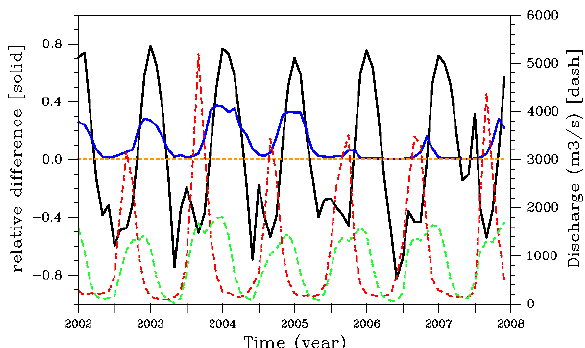
Fig. 6. Time evolution of the relative difference of simulated total evaporation between the simulation NOAQ-NF(1) and NOAQ-F(2) when the model is forced by TRMM-3B42 (solid blue line). The relative difference is the ratio ((2) − (1))/((2)+(1)). Time evolution of the relative difference of observed discharge between Niamey and Koulikoro (solid black line). Time evolution of the discharge in Niamey (dashed green line) and Koulikoro (dashed red